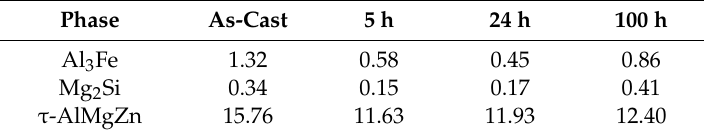
Table 3. Phase quantification of samples of series 1 (% phase).